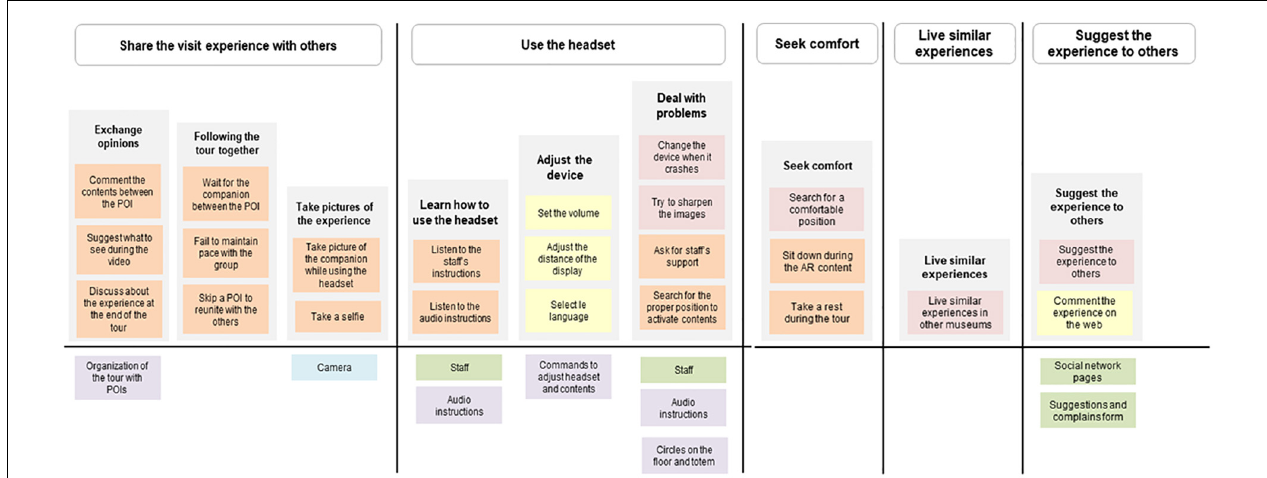
FIGURE 3 | Third portion of the Activity Diagram representing: in the upper part, other core activities of the Ara as it was tour (share the visit with others, use the headset, and seek comfort) and two activities in the post-phase of the visit (live similar experience and suggest the experience to others); in the bottom part, the existing services/tools/information provided by both the Ara Pacis Museum and other service providers, that the visitors used to perform the above